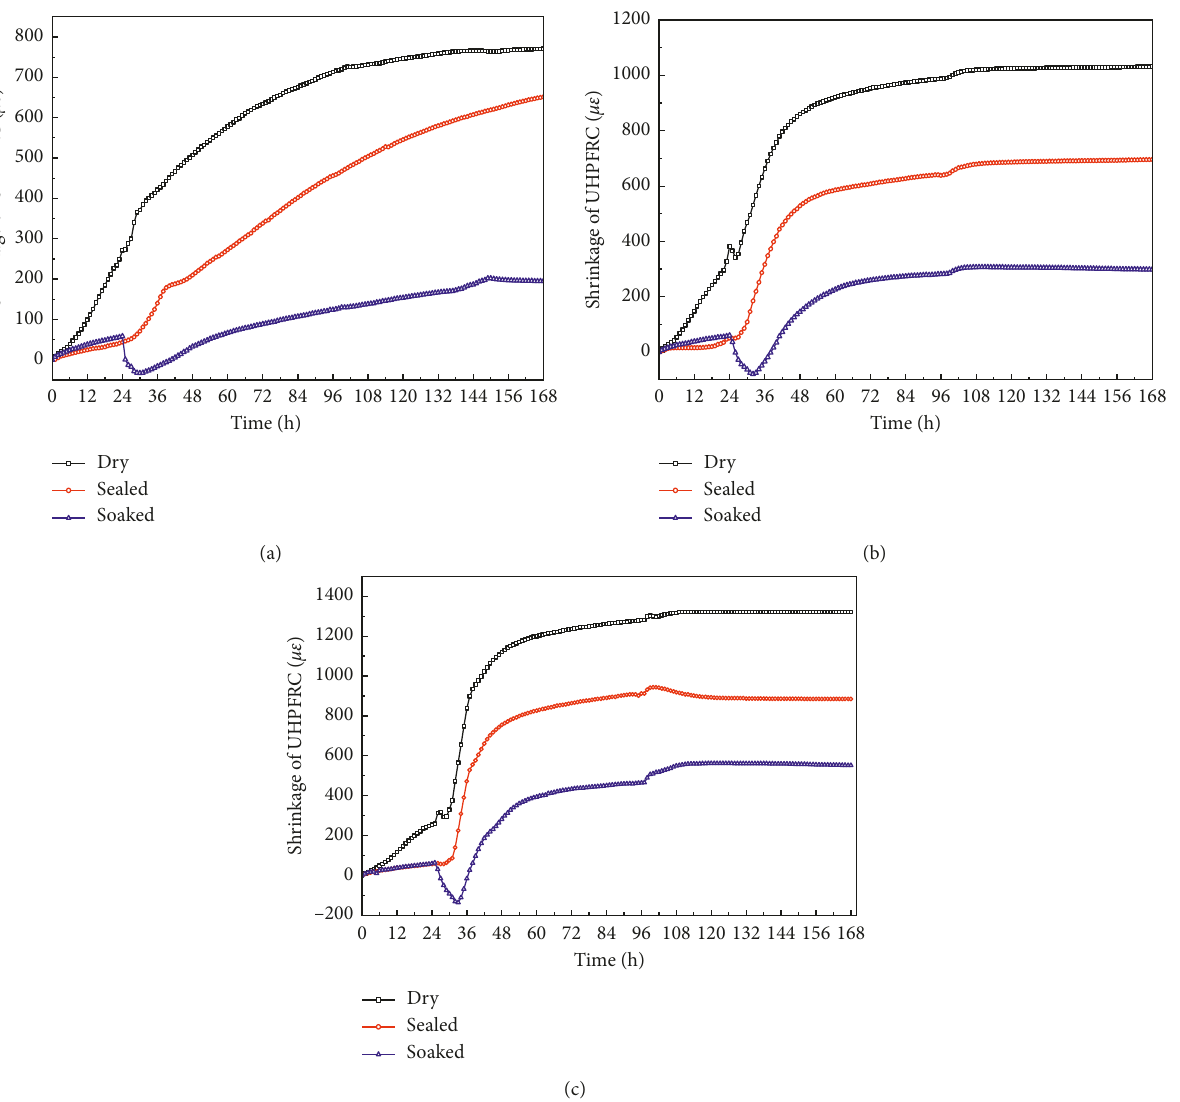
Figure 4: The shrinkage of UHPFRC in different temperature curing conditions in 168h. (a) 25 ° C. (b) 40 ° C. (c) 75 °